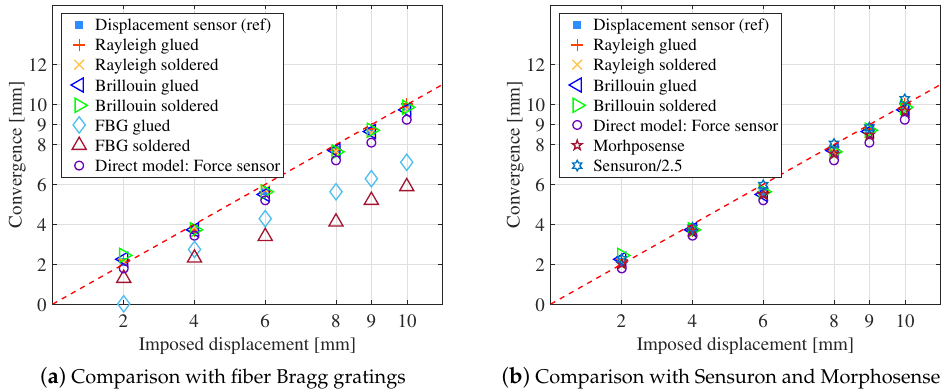
Figure 9. Convergence comparison between distributed optical fiber sensors and other systems.